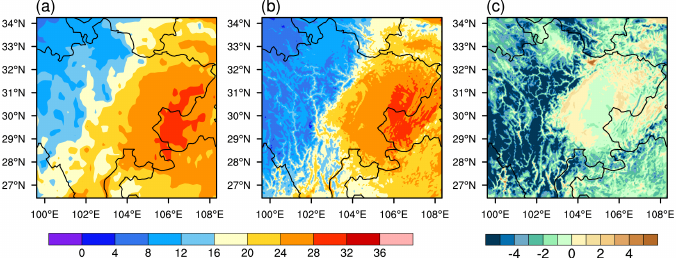
Figure A3. The comparison of the station observation ( a ) and WRF results ( b ) of 2-m temperature